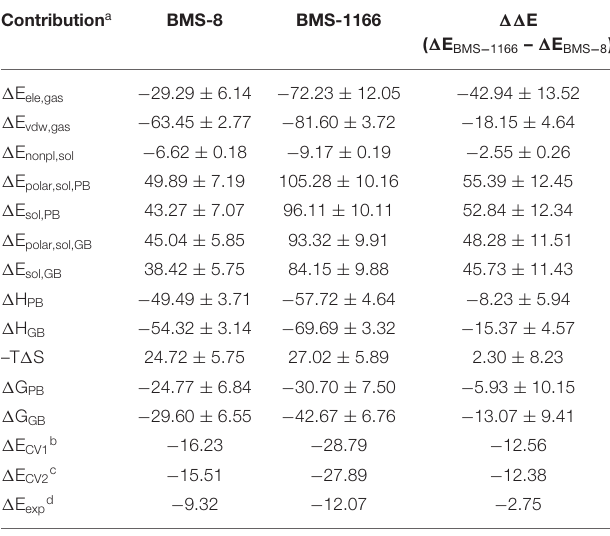
TABLE 2 | The binding free energies of BMS-8 and BMS-1166 evaluated by MM-PBSA, MM-GBSA, and metadynamics simulations. Contribution